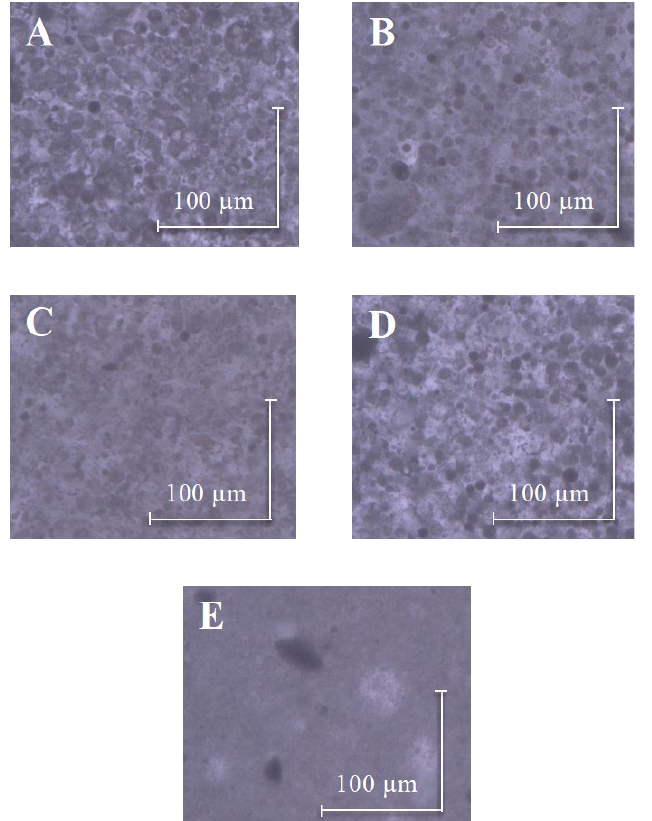
Figure 9. Optical microscope images of E+[TiO 2 +SSQ1] ( A ), E+[TiO 2 +SSQ2] ( B ), E+[TiO 2 +SSQ3] ( C ), E+[TiO 2 +SSQ4] ( D ), E+[TiO 2 ] ( E ).